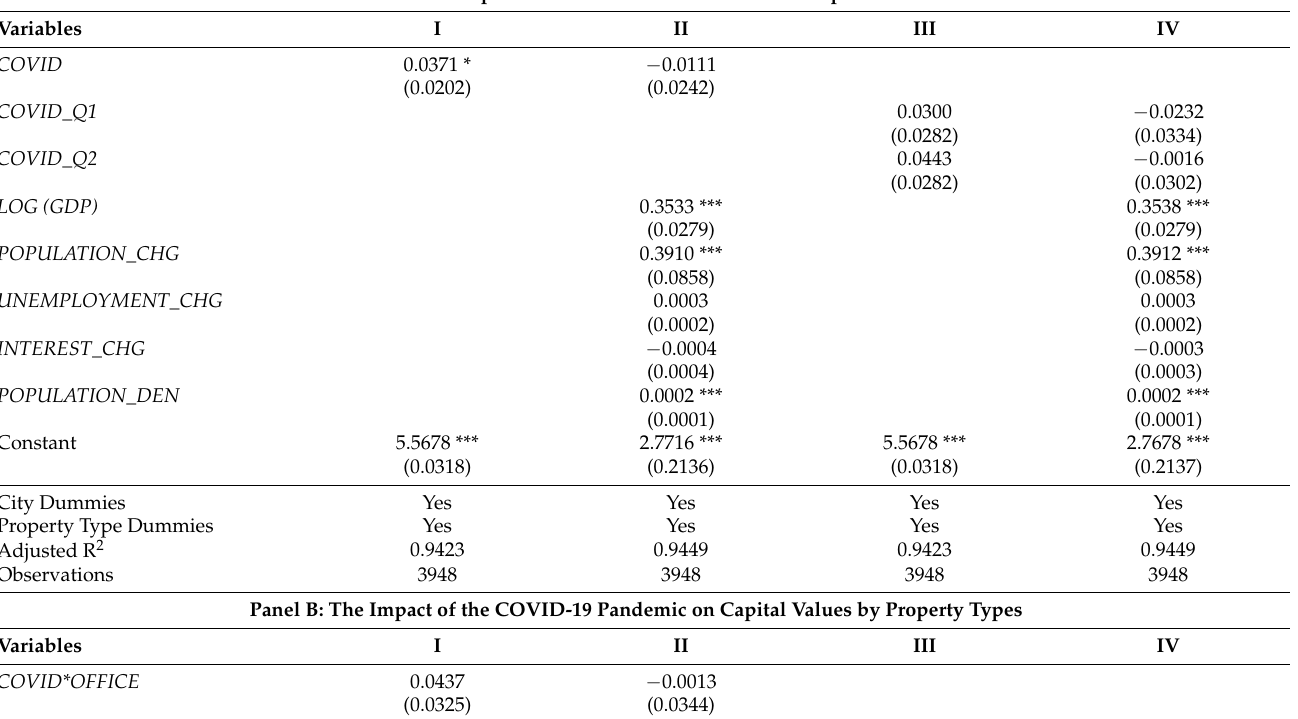
Table 6. Additional Analysis on Capital Values. This table presents the OLS regression estimation results of testing the impact of the COVID-19 pandemic on commercial real estate capital values. The dependent variable is LOG (CAPITAL_VALUE) , the natural logarithm of capital value for the specific city and property type. In Panel A, the independent variables of interest are COVID, COVID_Q1 and COVID_Q2 . In Panel B, the independent variables of interest are the interaction terms of COVID, COVID_Q1 and COVID_Q2 with the property type dummies. All variables are described in Appendix A. The standard errors are reported in parentheses. ***, **, and * denote significance of the t-statistics at the <1%, 5% and 10% levels,